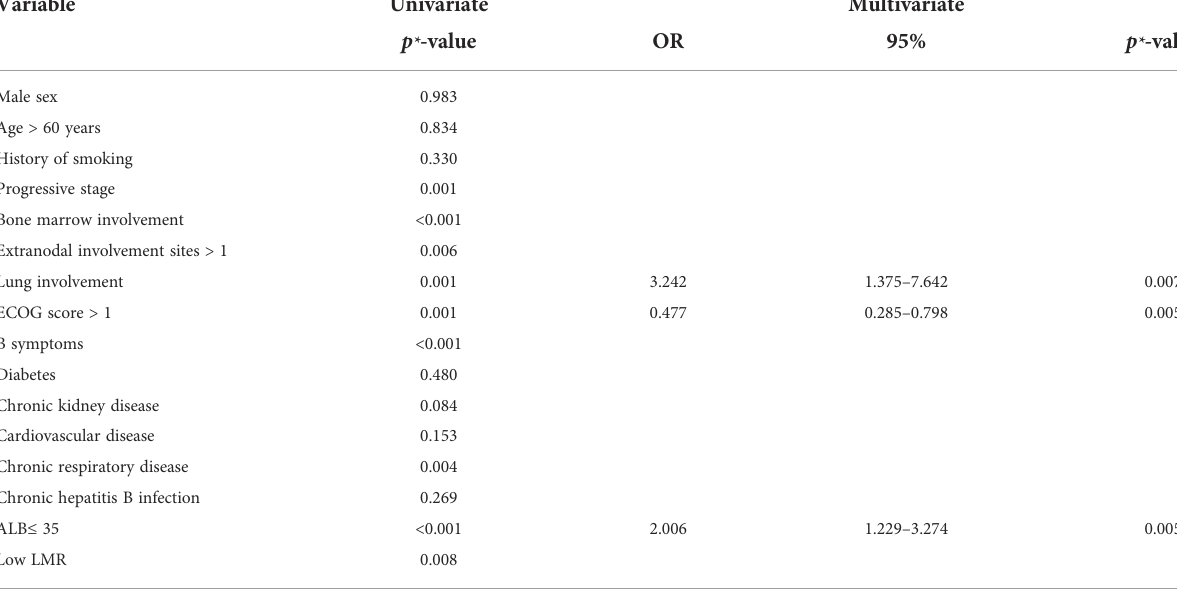
TABLE 3 Risk factors for development of pneumonia in DLBCL patients. Variable